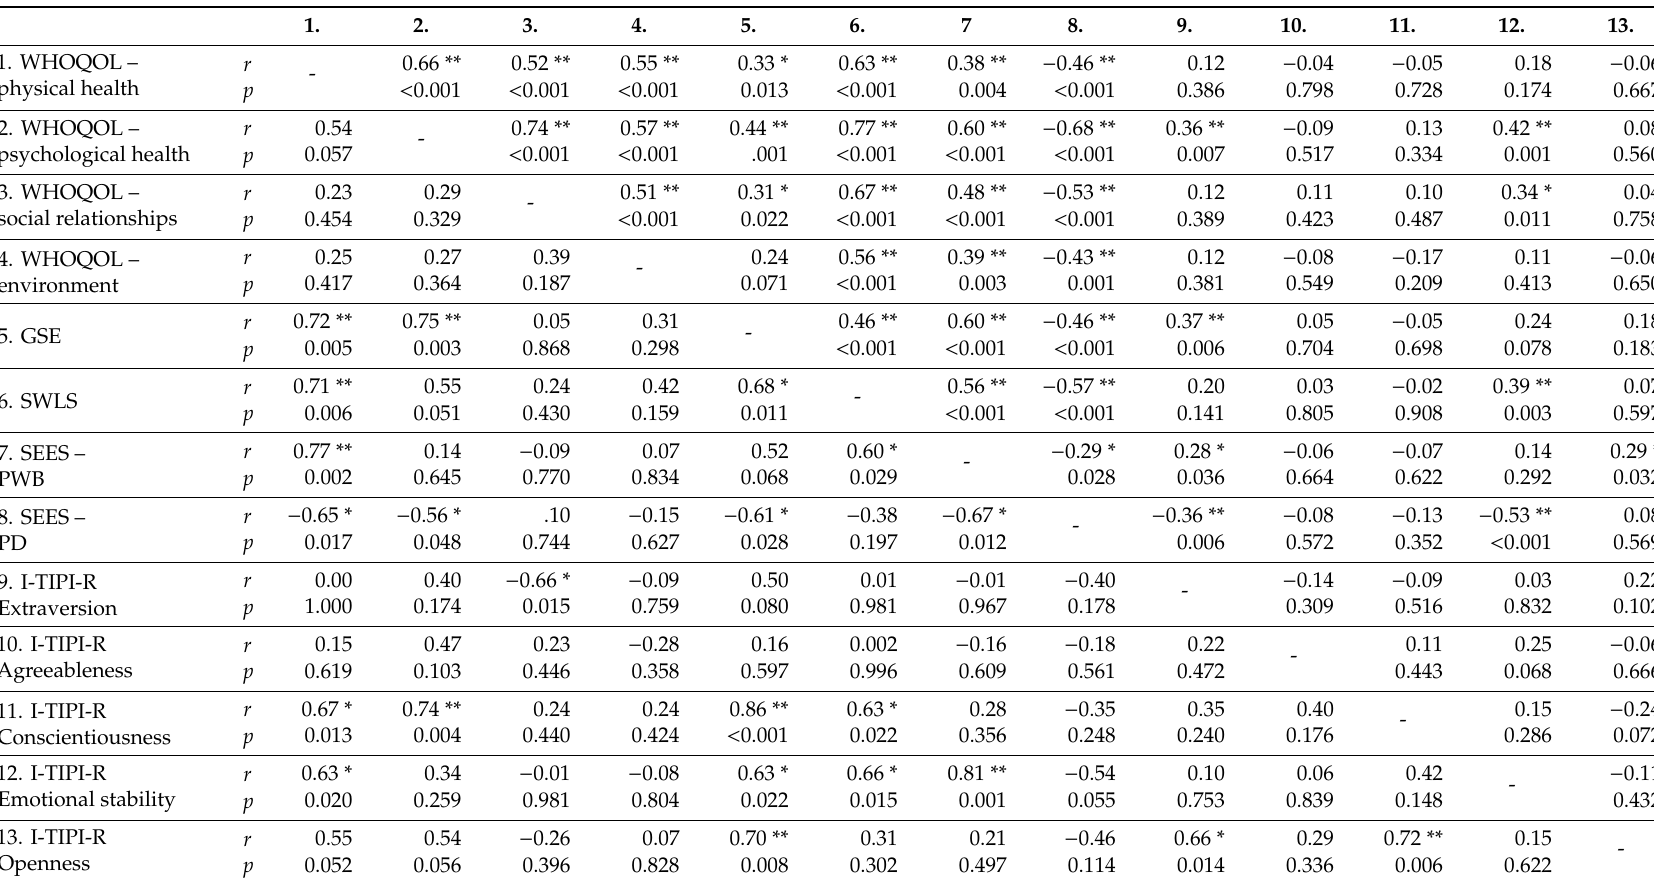
Table 5. Pearson’s r coe ffi cients between all scales calculated for participants not practicing sports: below the diagonal AD group ( n = 13), above the diagonal TD group ( n =